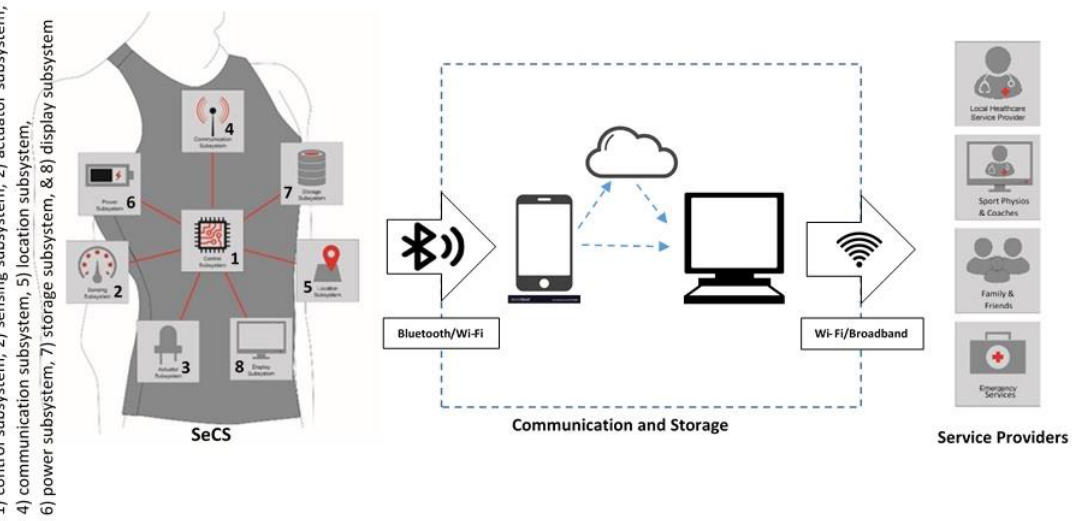
Figure 3. General system architecture of a SeCS.